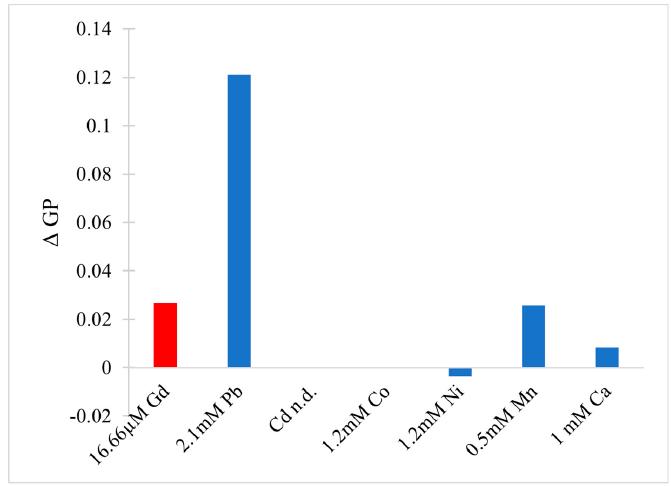
Figure 9. Generalized polarization of brain SM liposomes in the presence of various heavy metals. Only Gd, Pb, and Mn show appreciable effects. The Pb-assisted rigidification peaks at a metal concentration that is ~125 times higher compared to the concentration of Gd 3+ required to cause the same magnitude of effect. The changes due to addition of Mn are comparable to the ones observed with Gd 3+ but require a 30× higher metal concentration (Figure 9). Ca at ~60× higher concentration only induced a minor increase of GP (~1/3 of the Gd 3+ increase) (Figure 9). whose composition is shown in Figure 10. Figure 10. Lipid composition of porcine brain polar extract. Adapted from Avanti polar lipids; https://avantilipids.com/product/141101. This extract is made from total brain extract and contains ~20% negatively-charged lipids as potential metal binding targets. The total extract is produced with chloroform/methanol whereas the polar extract is isolated after treatment with acetone and diethylether according to the product information provided by the supplier Avanti Polar Lipids. Although Gd 3+ was used at a concentration substantially lower compared to other metal ions, it still induced the largest change in GP (Figure 11). Metal concentrations increases are approximated